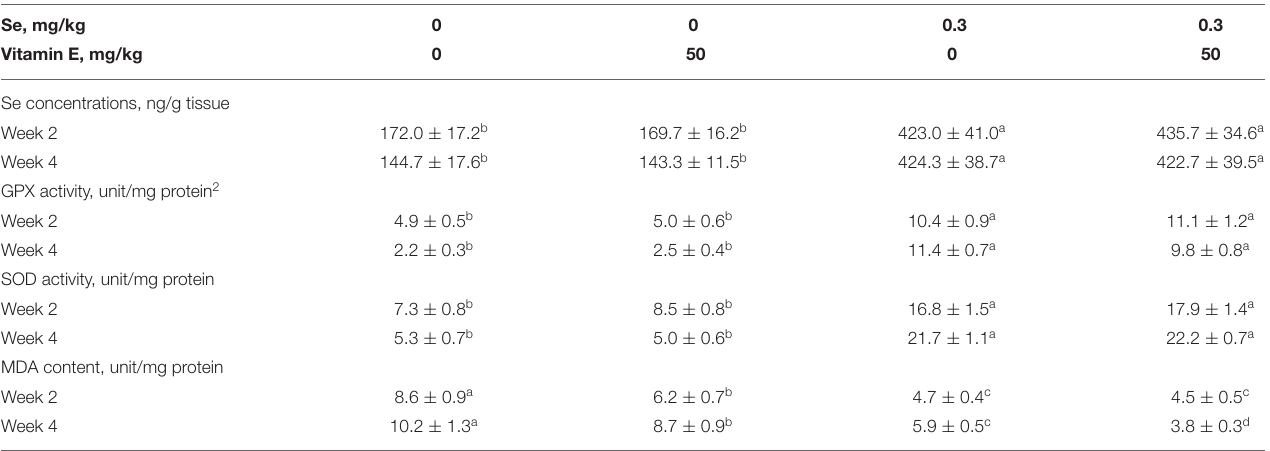
TABLE 3 | Effects of dietary Se and VE concentrations on Se concentrations of tissues and biochemical indicators in chick liver. Se, mg/kg